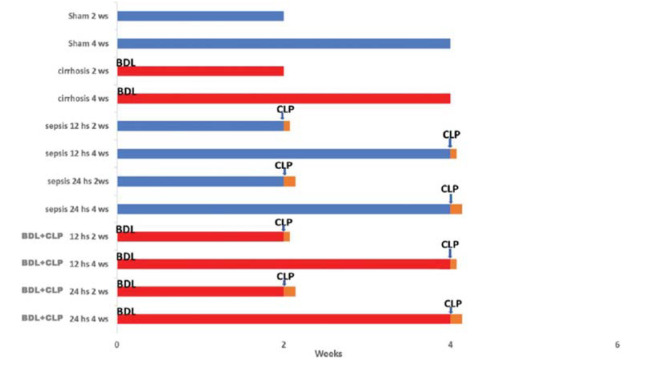
Animal distributions per group.